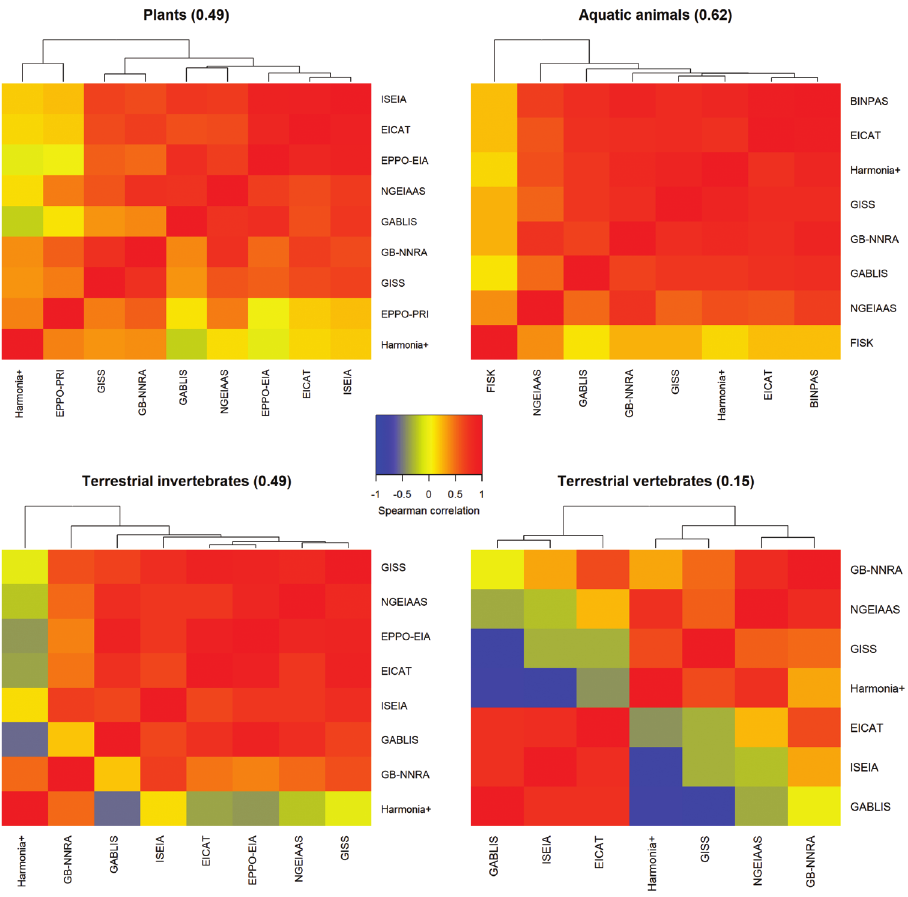
Figure 4. Spearman correlation matrix and hierarchical cluster of the species scorings for the protocols common per species group. The color scale indicates the correlation between the species scorings obtained for each protocol pair. In brackets, the mean of all pairwise correlations per